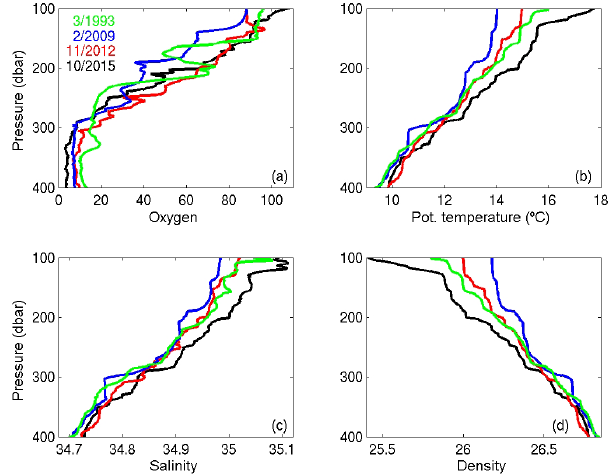
Figure 4. Upper 100m profiles at the Equator at 85 ◦ 50 (cid:48) W for 30 March 1993 (green), 12 February 2009 (blue), 2 November 2012 (red), and at the Equator at 85 ◦ 30 (cid:48) W for 7 October 2015 (black) for (a) oxygen in µmolkg − 1 , (b) potential temperature in ◦ C, (c) salinity, and (d) potential density in kgm − 3 .